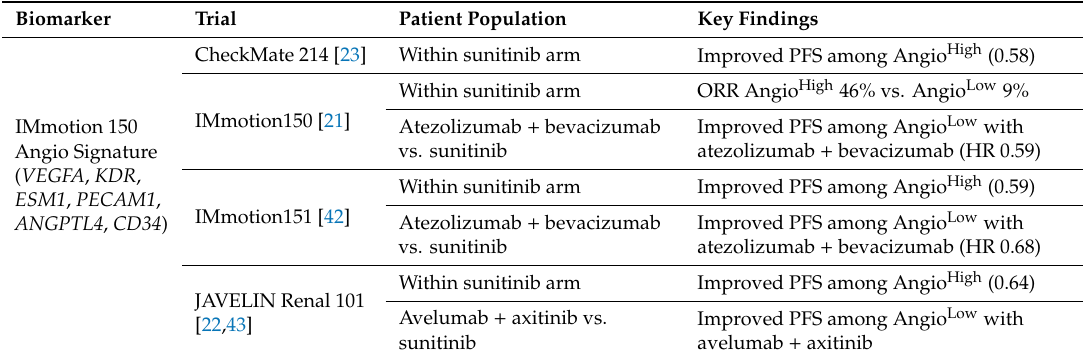
Table 2. Gene expression signatures evaluated from randomized controlled trials in mRCC. Biomarker Key